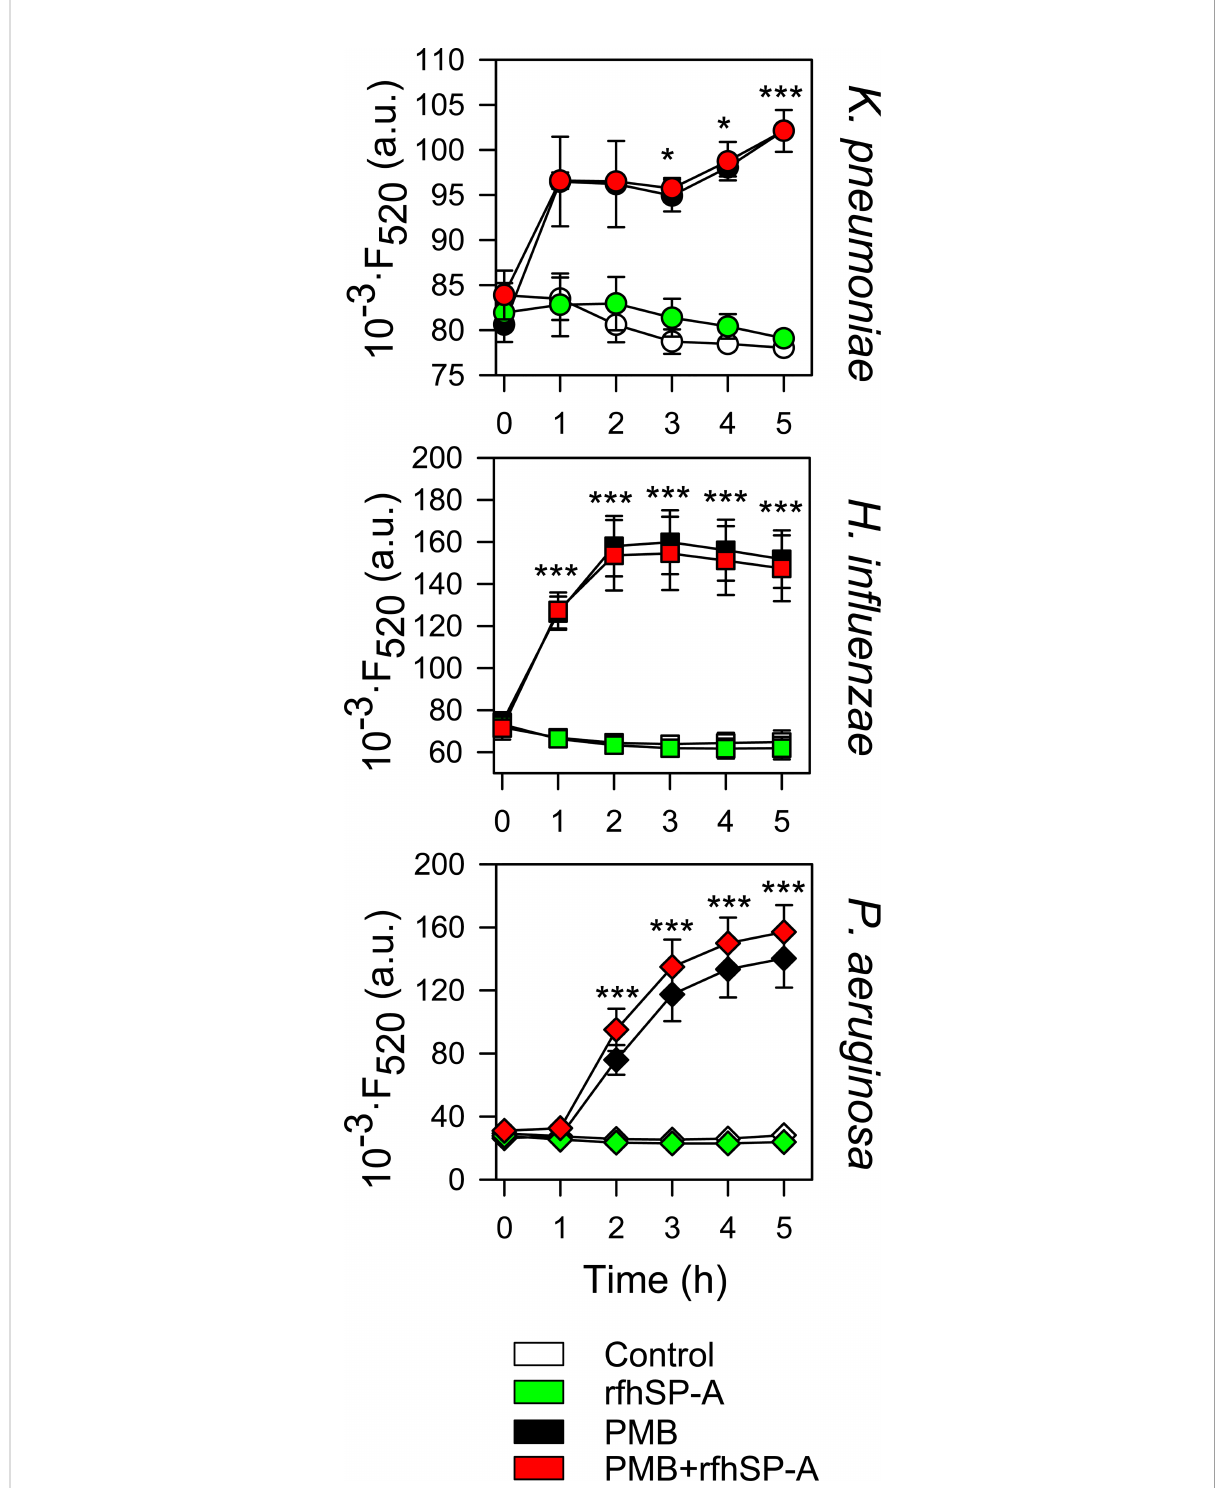
FIGURE 13 rfhSP-A does not affect the ability of PMB to permeabilize bacterial membranes. 10 7 CFU/ml of K. pneumoniae , NTHi, and PAO1 were incubated with PMB (1 m g/ml for K. pneumoniae ; 0.5 m g/ml for NTHi and PAO1) and/or rfhSP-A (5 m g/ml) in the presence of Sytox Green, and the change in the fl uorescence of the dye was recorded as a function of time. The results are the mean ± SD of three independent experiments, each in triplicate. A p -value < 0.001 was obtained for the one-way ANOVA followed by the Bonferroni multiple-comparison test: * p < 0.05 and *** p < 0.001 compared to untreated bacteria